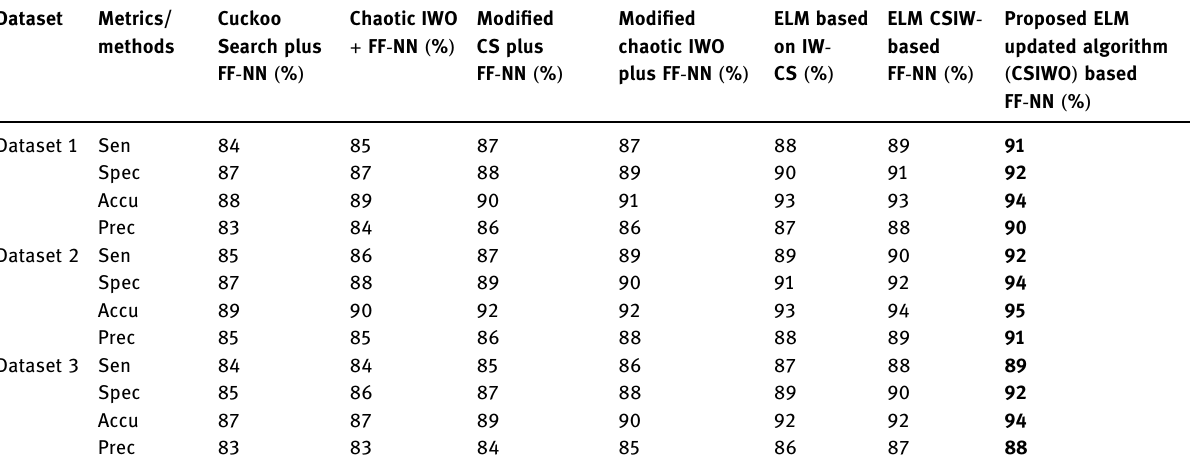
Table 2: Comparative discussion for objective value function Dataset Metrics/